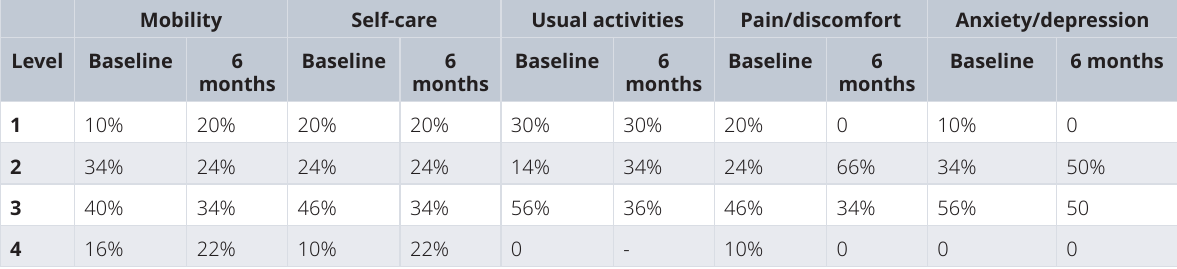
Table 6. Numbers and proportions reporting levels within the EQ-5D